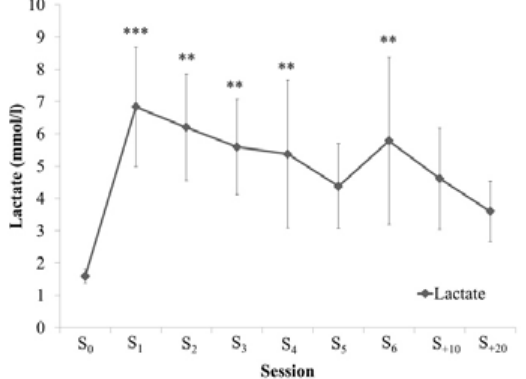
Figure 2. Blood lactate concentration recorded after each badminton session. Values are mean and standard deviation. A significant difference at the post hoc test with S 0 is indicated by *: P < 0.05; **: P < 0.01; ***: P < 0.001. Height decreased in both SJ (-13% , F 8, 88 = 3.0281, P < 0.001; η p = 0.226) and CMJ (-12% , F 8, 88 = 2.609, P = 0.014; η p = 0.224) (figure 3). Mean height in SJ was lower than CMJ ( P < 0.001, 31.82 v 36.03 cm respectively). The peak power in SJ decreased (-5.87%, F 8, 88 = 2.379, P = 0.024; η p = 0.209) and CMJ as well (-3.34%, F 8, 88 = 3.679, P < 0.001; η p = 0.290). Moreover, the mean values of relative peak power revealed a higher ( P < 0.001) value during CMJ (47.21